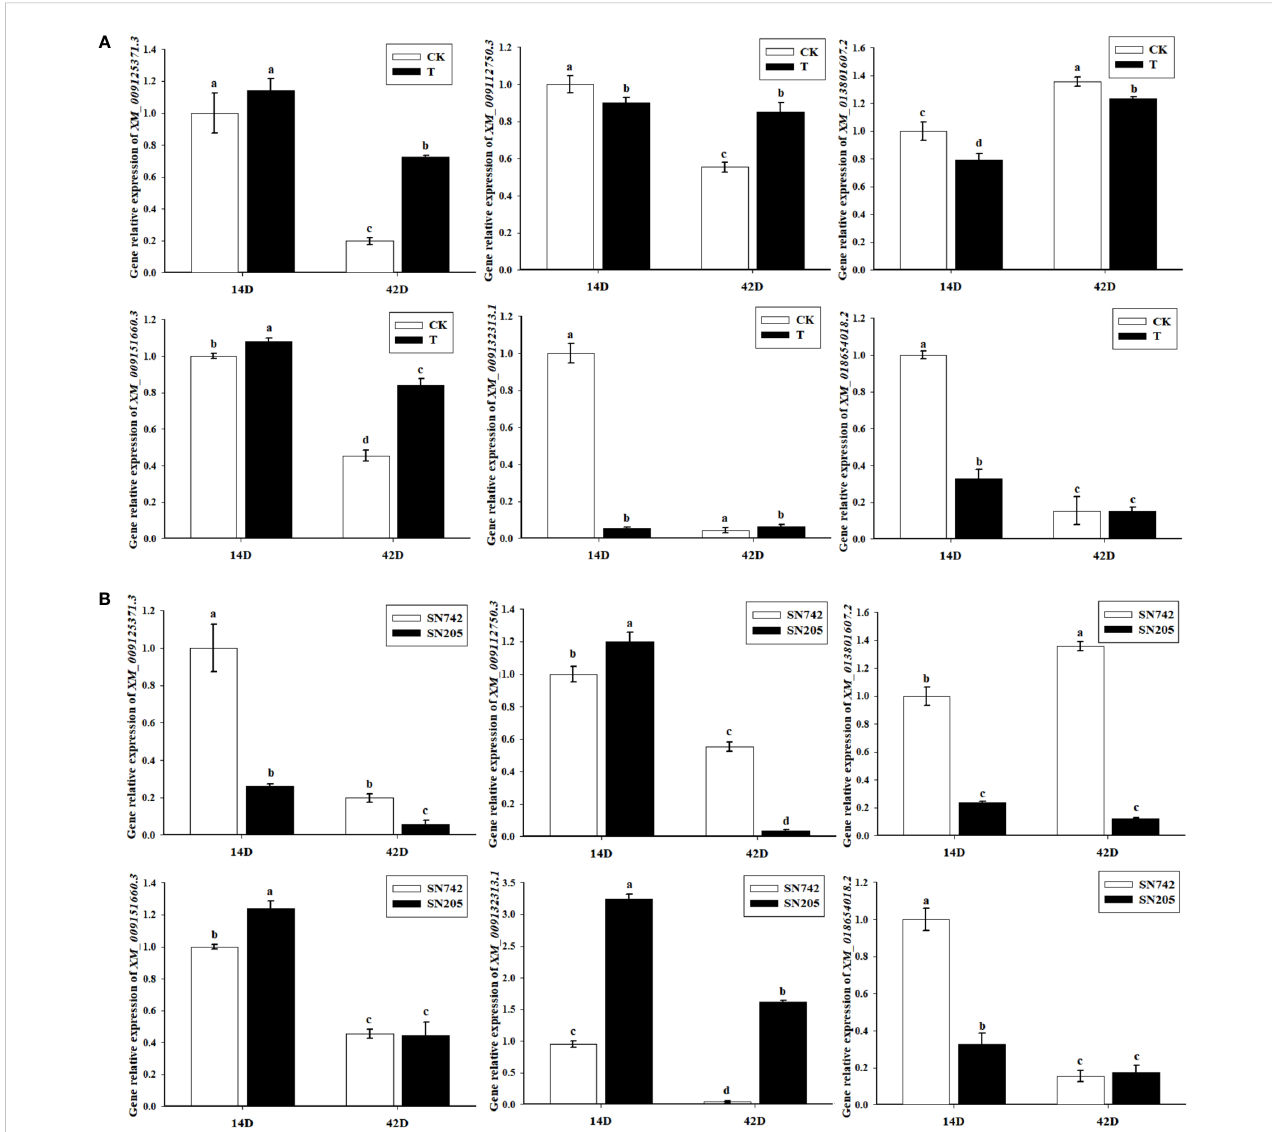
FIGURE 7 Gene expression pattern analysis of the candidate interacting protein of BrRPP1. (A) The expression difference of the candidate interacting proteins of BrRPP1 between uninoculated and inoculated roots with P. brassicae. 14D, the 14th day after inoculation of P. brassicae . 42D, the 42th day after inoculation of P. brassicae . CK, uninoculated control roots. T, roots treated with P. brassicae. (B) The expression of the candidate interacting proteins of BrRPP1 in roots of ‘ SN742 ’ and ‘ SN205 ’ uninoculated with P. brassicae . Data represent the mean ± standard deviation (n = 3); letters indicate signi fi cant differences at p ≤ 0.05, according to Duncan ’ s multiple range